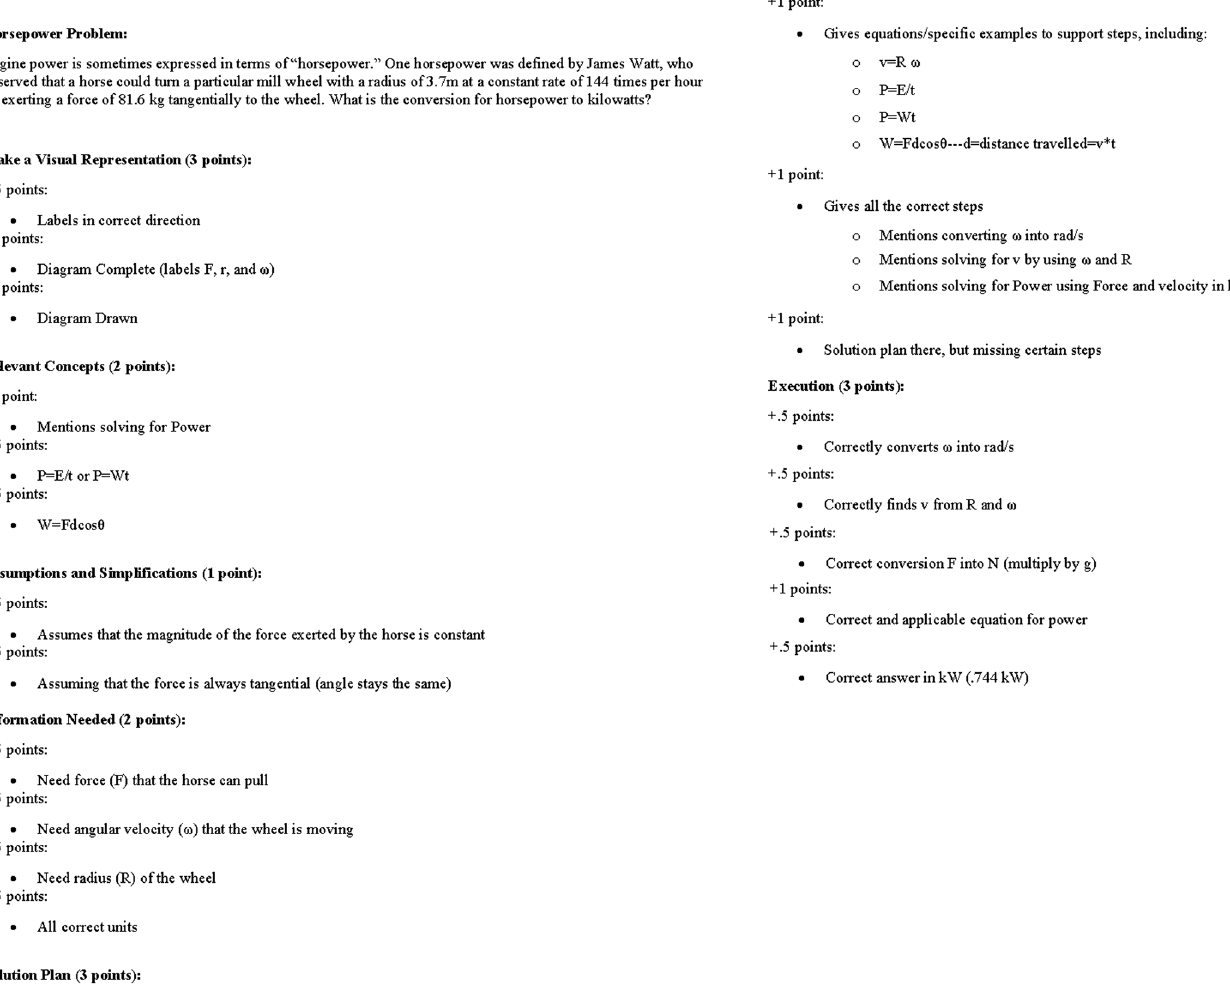
FIG. 10. Rubric for horsepower